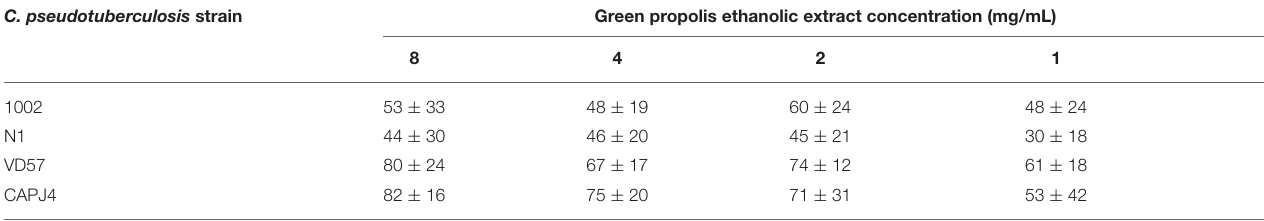
TABLE 5 | Interference by the green propolis ethanolic extract in the formation of C. pseudotuberculosis